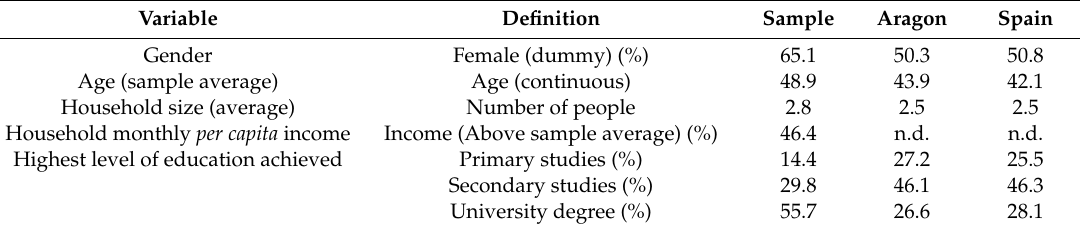
Table 2. Socioeconomic variables of the sample, Aragon and Spanish